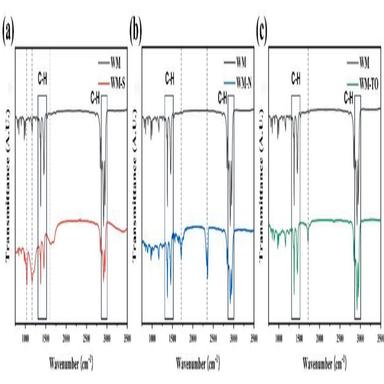
FT-IR spectra of WMs before and after different pretreatments: (a) sulfonation; (b) nitration and (c) thermal oxidation.